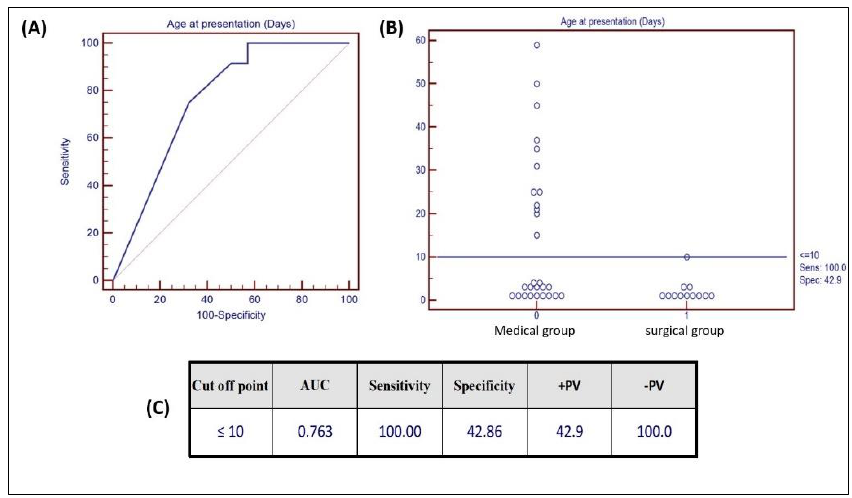
Figure 3: (A): Receiver operating characteristic curve (ROC) for age at presentation (days) as a predictor to differentiate between medical and surgical cases; (B): Patient’s distribution according to the age at presentation (days) in both groups; (C): Area under the curve (AUC) and sensitivity and specificity of the cutoff point.